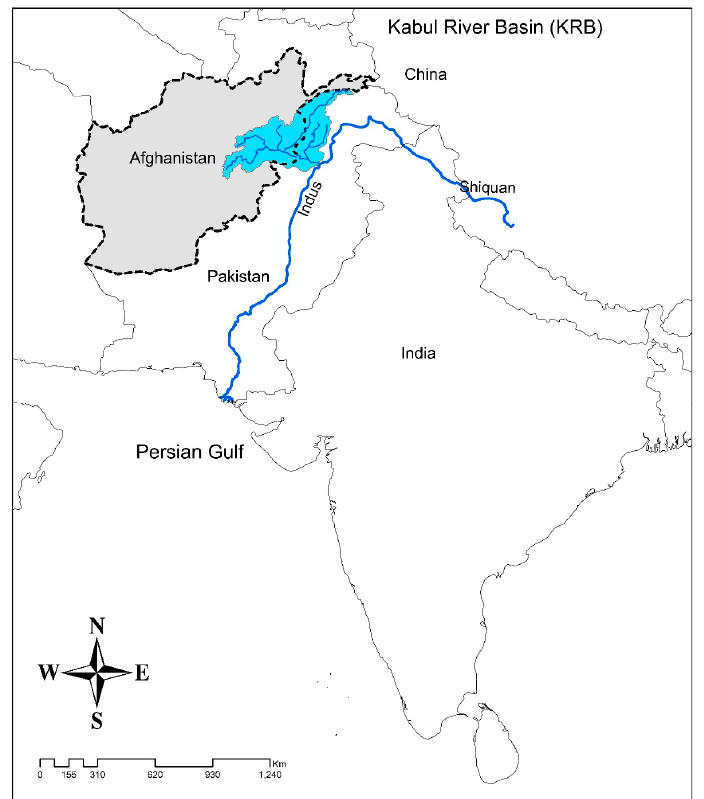
Figure 1. Location of the Kabul River Basin .